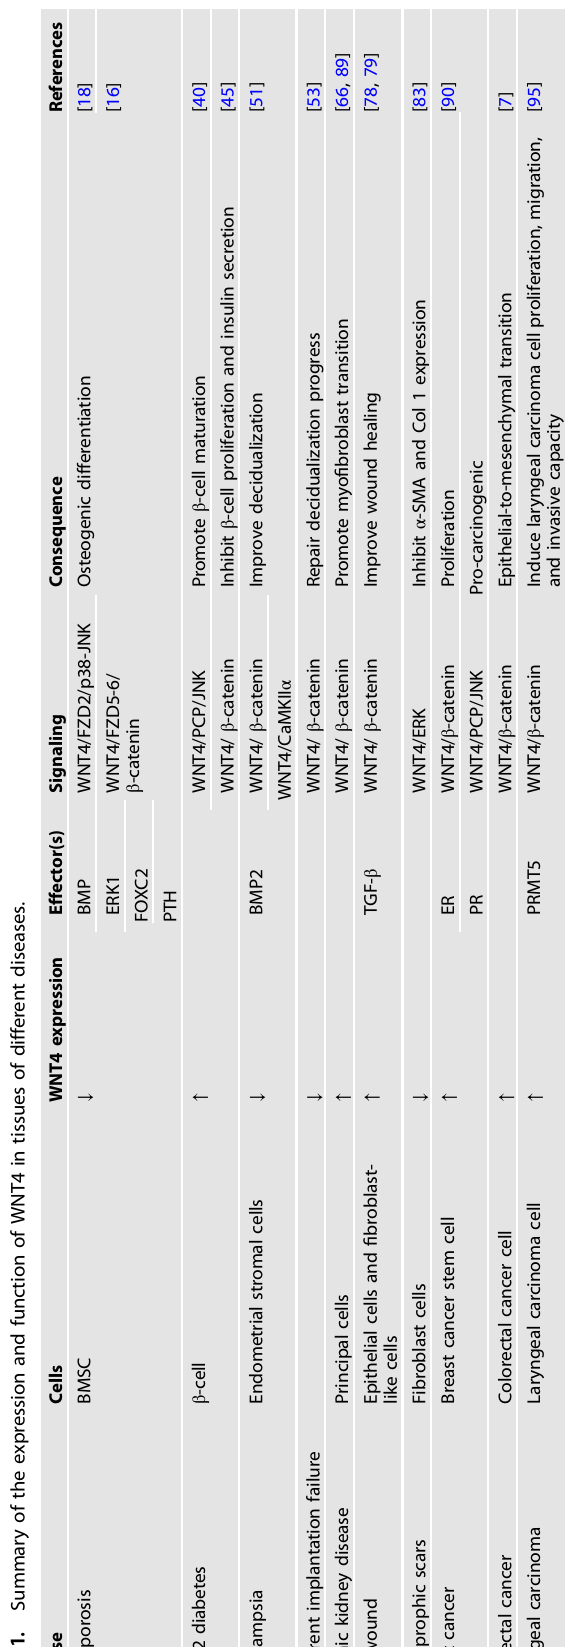
from the body or the cell itself. In addition to the critical role in embryonic development, cell differentiation also plays roles in various organisms, especially complex mammals, throughout their lives. Adult stem cell is a class of cells with multiple differentiation potentials existing in multiple areas of the body. It is currently known that WNT4 plays a role in mediating cell differentiation, including osteogenic differentiation, β -cell mutation, decidual cell decidualization, neuro-differentiation, dendritic cell (DC) differ- entiation, and myo fi broblast differentiation and participates in the occurrence and progression of various diseases (Fig. 3). Role of WNT4 in osteogenic differentiation Osteoblasts are important cells in the bone tissue, playing a key role in bone formation and maintenance of bone mass. BMSCs are the natural source for bone regeneration and can differentiate into osteoblasts. Then osteoblasts undergo three differentiation steps, including division growth, ground substance maturation, and mineralization. WNT4 protein is increased during differentiation of BMSCs to osteoblasts [31, 32]. WNT4 may play an important role in the crosstalk between BMP2 and RUNX1 [33]. WNT4 is also essential for melatonin-induced bone formation in the in fl amma- tory environment both in human BMSCs and MC3T3-E1 pre- osteoblasts [16], in which ERK1/2-PAX2-EGR1 pathway was found to promote WNT4 transcription and expression. It was reported [18] that the transcription factor FOXC2 could transcriptionally regulate WNT4 expression during osteogenic differentiation of BMSCs. An early study [32] demonstrated that WNT4 could enhance osteogenic differentiation of BMSCs in vitro through activating p38 MAPK but not β -catenin pathway. But some recent target-speci fi c small interfering RNA experiments [16] demon- strated that WNT4 could mediate the p38-JNK signaling pathway through interacting with Fzd2 and activate the β -catenin signaling pathway through interacting with Fzd1-LRP5 and Fzd6-LRP6 to induce osteogenesis. According to the latest view, WNT4 induces osteogenesis through both β -catenin and p38-JNK signaling pathways. Human dental pulp stem cell (DPSC) is an autologous promising seed cell for bone tissue engineering. It was reported [34] that loss of WNT4 expression in DPSC inhibited odontogenic differentiation while overexpression of WNT4 in lipopolysaccharide-treated DPSC promoted odontogenic differentiation through JNK1 signaling pathways. WNT4 can also elevate osteogenic potential of stem cells from in fl ammatory dental pulp tissues for treating bone defects in rats [35]. WNT4 also plays a key role in promoting the osteogenesis process of adipose-derived stem cells (ADSCs) [36], which can be induced to differentiate into osteoblasts to mineralize extracellular matrix (ECM) and express proteins associated with bone phenotypes [37]. In ADSCs, parathyroid hormone (PTH) promotes the osteogenesis process through enhancing the expression of WNT4 [36]. Role of WNT4 in β -cell maturation Islet dysfunction and destruction lead to the hypofunction of insulin secretion, which is the common cause for both type 1 and type 2 diabetes mellitus (T2DM). The islets of Langerhans are highly vascularized miniorgans, so improving the mutation of islet β -cells and preserving the structural integrity and full function of the microvascular endothelium are two strategies for protecting the islets against in fl ammatory and oxidative stress assaults. Studies have shown that WNT4 is the most abundantly expressed WNT ligand in β -cells and its expression is enhanced during the postnatal functional maturation of human (mouse) islets. Its expression is enhanced by the high-fat high-sucrose diet [38 – 40]. Activating the non-canonical WNT4/PCP/JNK pathway has been demonstrated to induce β -cell maturation and increase glucose- T a